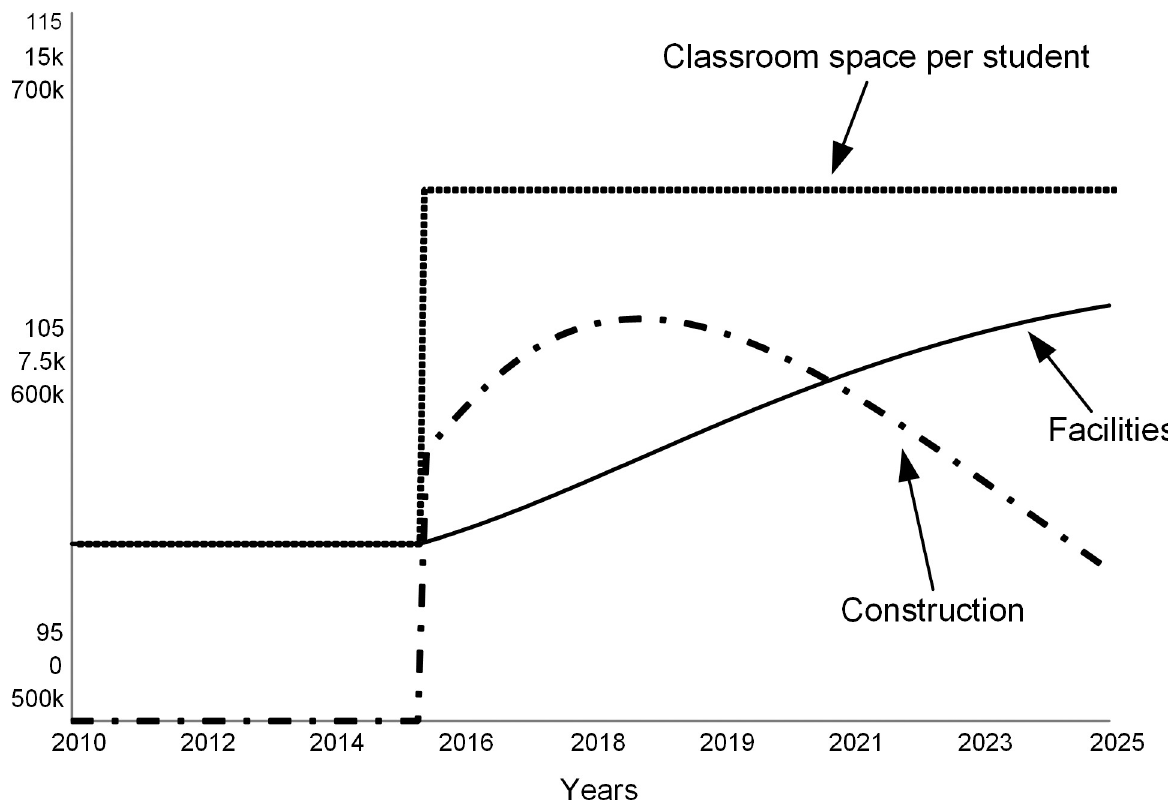
Fig 16. Facilities hike. In 2015, college decides to increase classroom space per student, and therefore starts new construction. Over time, the amount of available facilities increases to satisfy the new